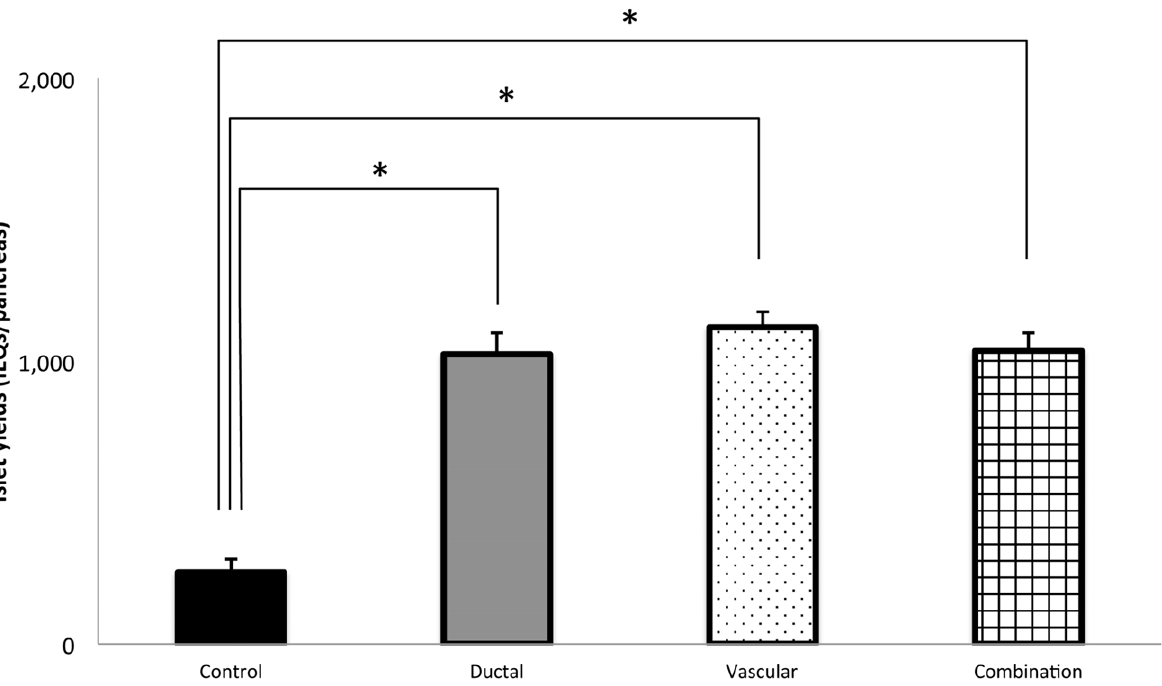
Figure 2. The effects of ductal injection and/or vascular perfusion on the islet yield (UWS). In the UWS model, the isolated islet yield significantly increased in the ductal injection (gray bar: ductal group: n=10), vascular perfusion (dotted bar: vascular group: n=9), and ductal injection/vascular perfusion groups (squared bar: combination group: n=10) in comparison to that of the cold ischemia control group (black bar: control group: n=10). No significant differences were observed among the ductal, vascular, and combination groups. * P , 0.0001.